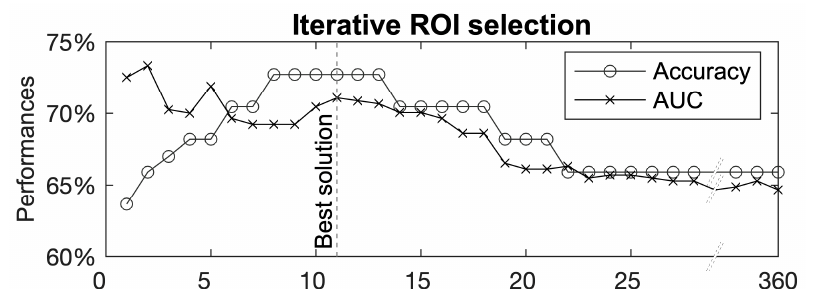
Figure 1. Post hoc analysis to select the subset of ROIs that contributed most to the classification. The X -axis reports the number of ROIs used for the classification. The Y -axis reports classification performance scored with that set of ROIs. ROIs are iteratively removed from the lowest to the highest weight, which was assigned by assessing all of them. The red dashed line indicates the best configuration.